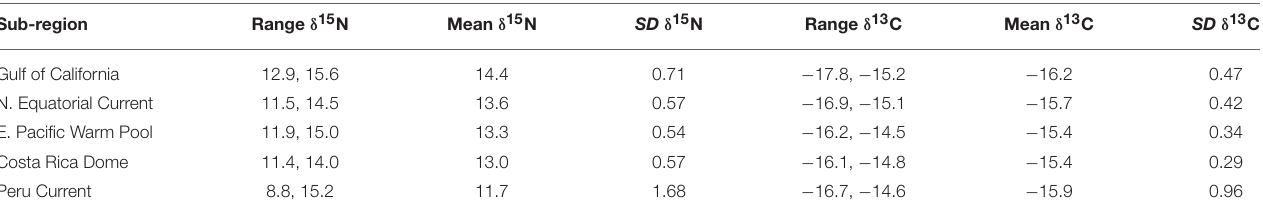
TABLE 1 | Bulk δ 15 N and δ 13 C ( ‰ ) information summarized by oceanographic sub-region, listed in latitudinal order from north to south.